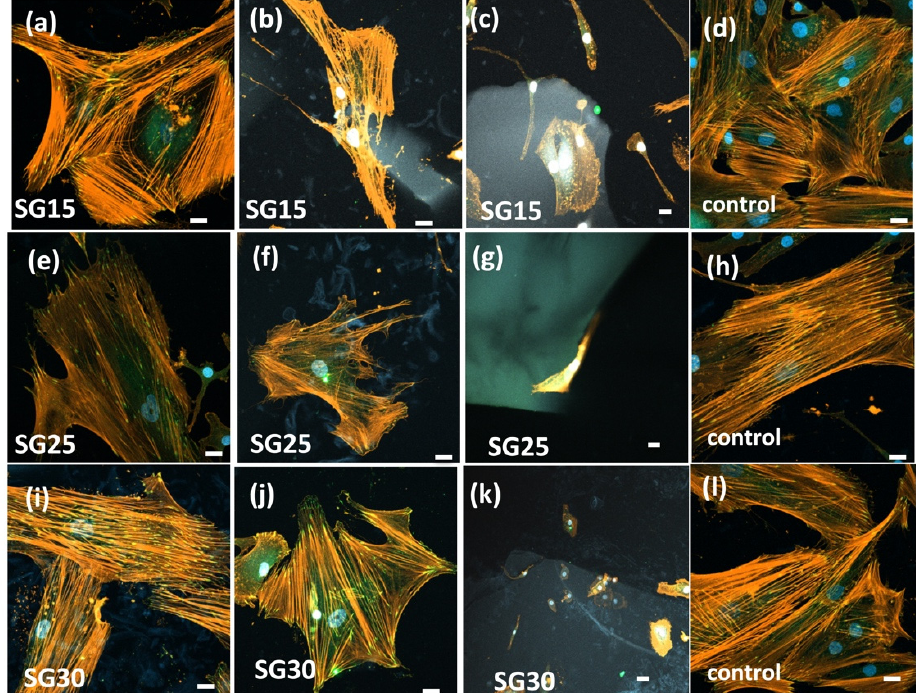
Figure 10. Representative images of HOB ® osteoblasts after one week of culture, grown in the presence of SG15 ( a – c ), SG25 ( e – g ), and SG30 ( i – k ) aerogels, and control groups grown on glass ( d , h , l ). Images were acquired using a confocal microscope, after immunolabelling the actin cytoskeleton with rhodamine phalloidin (red fluorescence) and vinculin (green fluorescence) to detect focal adhesions. Blue—DAPI-labelled nuclei. Unless otherwise specified, the scale bar is 20 μ m.